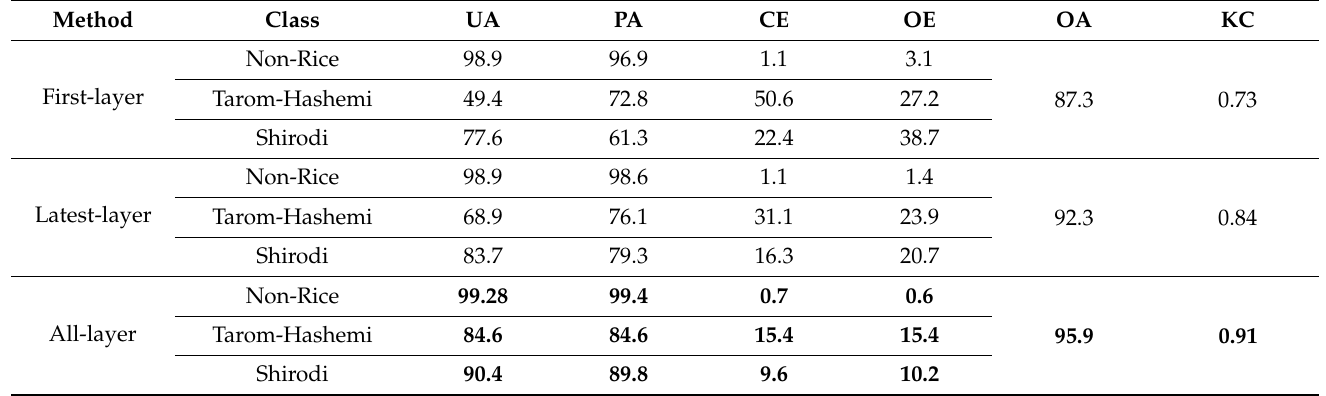
Table 7. Comparison of different strategies for deep feature fusion. The bold values show the highest